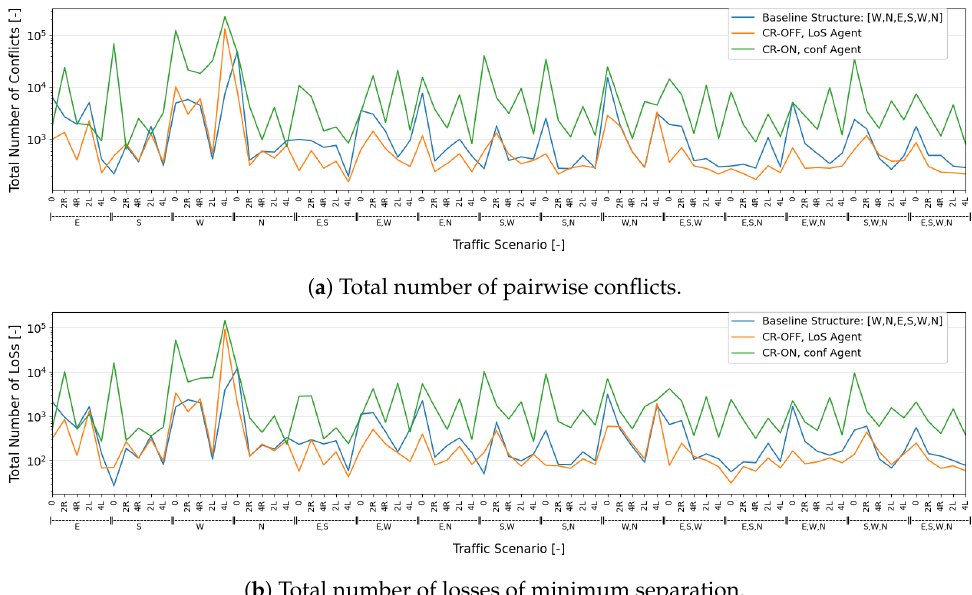
Figure 12. Final comparison of the best RL agents during training in an environment without conflict resolution. The results are directly compared using a baseline, fixed